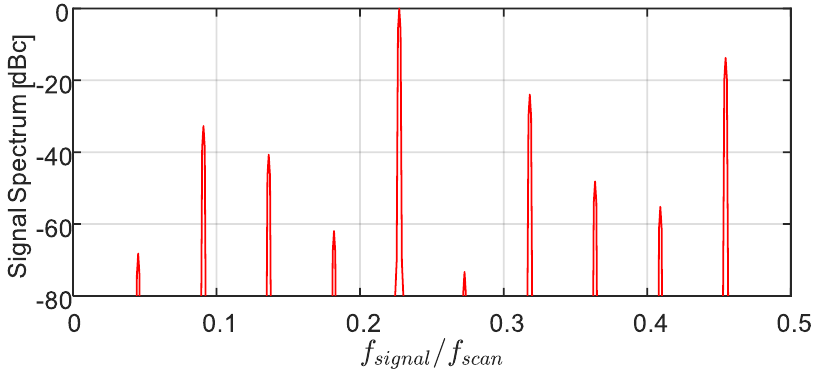
Figure 3. Hamming-weighed FFT-based spectrum of the signal acquired from its per-period inter- sections with the saw-tooth scanning waveform (Figure 1), exhibiting significant harmonic distor- tion. The highest harmonic at 𝜉 = 0.46 is the signal ’ s second harmonic, whereas the other peaks are folded ones (see text). The time record was 1100  𝑇 𝑠𝑐𝑎𝑛 long, starting at − 550  𝑇 𝑠𝑐𝑎𝑛 . Incidentally, using the true signal values on the same temporal grid of period 𝑇 𝑠𝑐𝑎𝑛 , gives rise only to a single peak at 𝜉 =